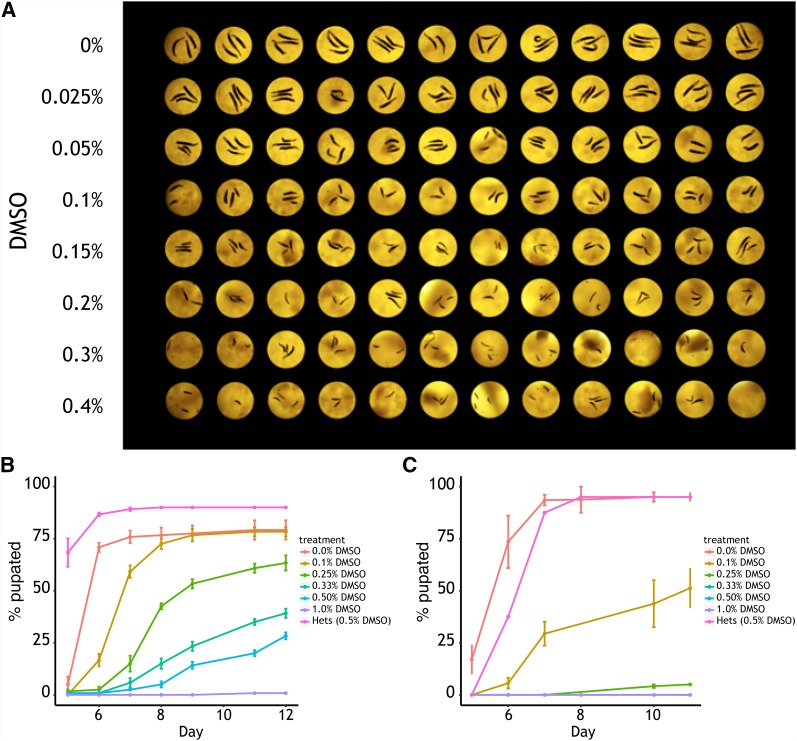
PnglPL homozygotes are hypersensitive to dimethyl sulfoxide (DMSO). A) An image of PnglPL homozygous larvae grown in 96-well plate format on food dosed with different concentrations (0–0.4%) of DMSO. PnglPL homozygous larvae are hypersensitive to DMSO, a decrease in larval size is observed starting at 0.025% DMSO and larval size is decrease as the dose of DMSO is increased. The time to pupation of B) PnglEx20 (n = 3 replicates, 20-30 individuals/replicate) or C) PnglPL (n = 5 replicates, 20-30 individuals/replicate) homozygous larvae reared on food treated with DMSO. Homozygous mutant larvae exhibit hypersensitivity to DMSO showing a delayed time to pupariate and increased lethality.